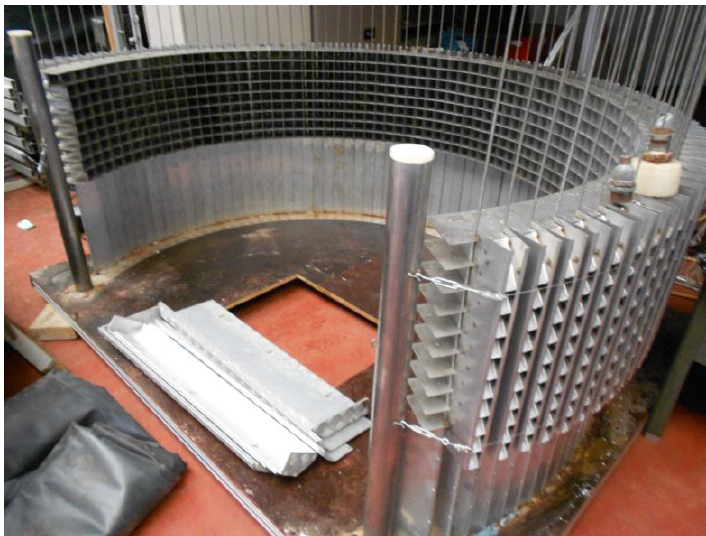
Figure 5. Cylindrical collector used for validation of the